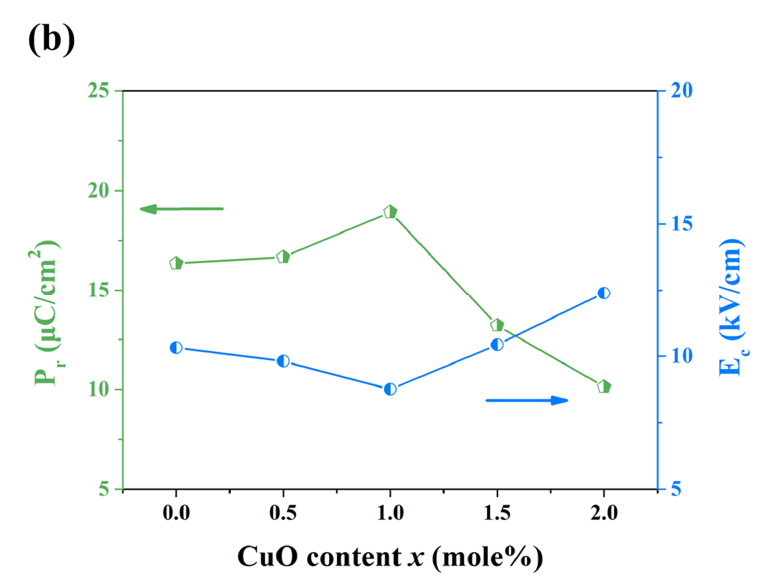
Figure 6. ( a ) Ferroelectric hysteresis loop ( P - E loop) and ( b ) Remnant polarization P r and coercive electric field E C of the NKLNTS-ST- x CuO ceramics measured at 1 Hz and room temperature.